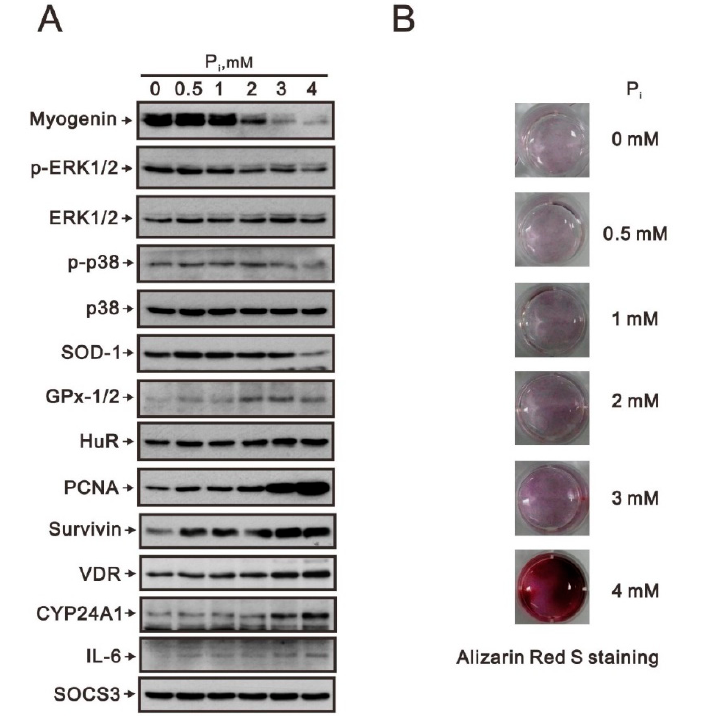
Figure 2. The effects of high P i on myogenin and its associated proteins in differentiated C2C12 cells. After induction of differentiation by culturing C2C12 cells in differentiation medium for 3 days, differentiated C2C12 cells were treated with the indicated concentration of P i for 24 h. ( A ) Cell lysates were subject to immunoblot analysis against indicated proteins. ( B ) Cells treated with P i were stained with Alizarin Red S dye.